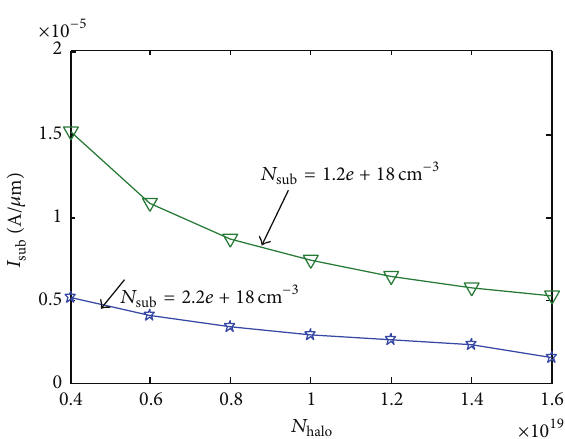
Figure 11: Drain current as a function of halo doping.